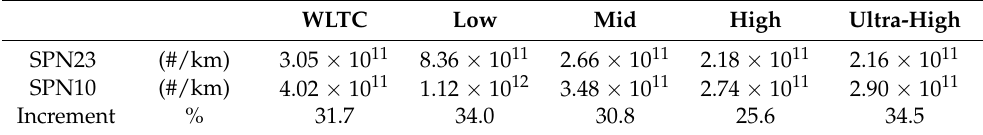
Figure 2. Comparison between SPN23 and SPN10 emissions over the WLTC. Table 3. Distance-based PN results of SPN23 and SPN10 over the WLTC.